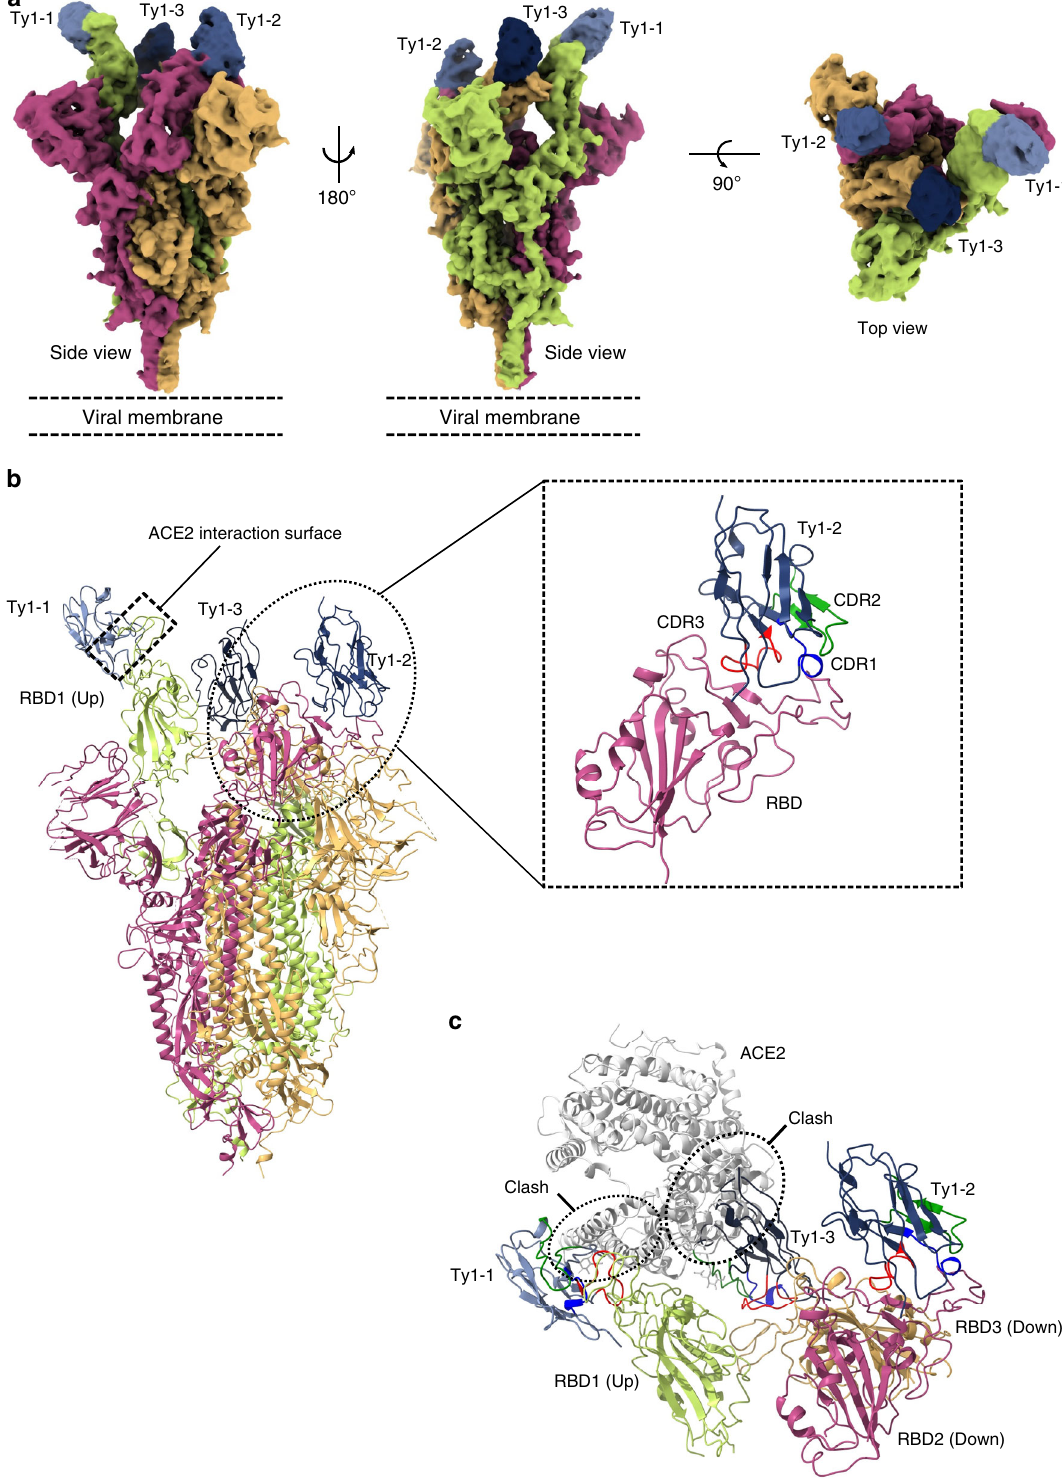
Fig. 4 Ty1 binds to the RBD in ‘ up ’ and ‘ down ’ conformation and prevents ACE2 engagement. a Cryo-EM reconstruction to an overall resolution of 2.9 Å (0.143 FSC) of the spike trimer with three bound molecules of Ty1. b Atomic model (cartoon representation) of trimeric spike in complex with three molecules of Ty1. Three chains of spike are shown in three different colors. The RBD of chain A (light green) is present in ‘ up ’ conformation while the other two RBDs are captured in ‘ down ’ conformation. The ACE2 interaction surface of RBD1 and the Ty1 interaction surface is highlighted. Magni fi ed view of RBD2 (in ‘ down ’ conformation) and Ty1 interaction is shown. CDR1, 2, and 3 of Ty1 are shown in blue, green, and red, respectively. c Ty1 shows a two- pronged inhibition of ACE2 receptor binding through binding the RBD in the ‘ up ’ conformation and by binding to the neighboring RBD in the ‘ down ’ conformation. Binding of Ty1 to RBDs (both ‘ up ’ and ‘ down ’ ) would make ACE2 interaction surface inaccessible for